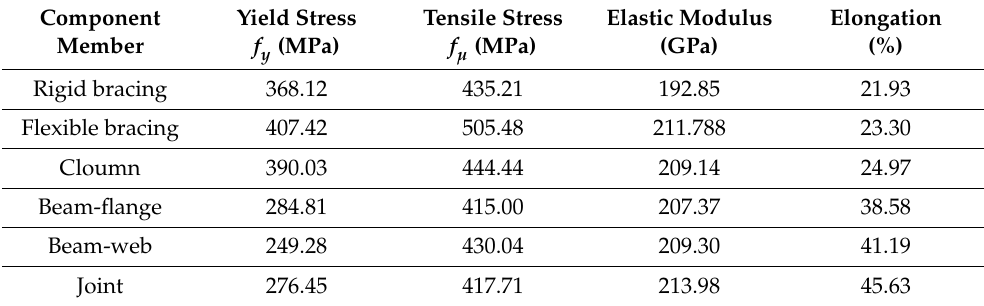
Table 2. Material properties of the steel members.